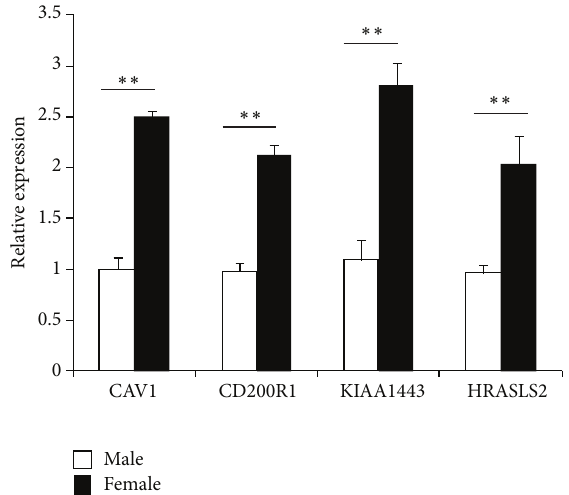
Figure 2: Validation of top 4 DEGs by qRT-PCR. The expression of 4 genes by the microarray was analyzed by QRT-PCR. Bar graph show real-time PCR expression of CAV1, CD200R1, KIAA1443, and HRASLS2 in B cells from healthy males and females. The data are presented as relative expression following normalization. Data represented mean ± SE. ∗∗ 𝑃 < 0.01 versus